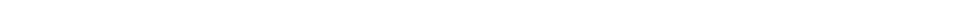
(see fi gure on previous page) Fig. 5 Cytotoxicity of BSO and DPI combinatory treatment in murine KPC cells. A qRT-PCR analysis of pancreatic CYBA gene expression. At 60 days of age, randomly recruited male and female fElas CreERT ( n = 4), KRAS G12D/ + ( n = 3), and KPC mice ( n = 6) were treated with TM. Three weeks post TM induction, the pancreata were collected for RNA extraction. β -actin serves as a control. B An equal number of KPC cancer cells were seeded in 6-well plates and treated with DPI at 0, 3, or 10 μ M in the presence or absence of 100 μ M BSO for 48 h. Cell morphology, population growth, and death were observed under a light microscope. KPC cells without any treatment served as the control. Scale bar, 200 μ m. C Total cellular glutathione (GSX) was measured after 24 h of BSO treatment at 0, 100, or 200 µM in KPC cells by spectrophotometry. D KPC cancer cells were treated with 3 or 10 μ M DPI alone, 100 µM BSO alone, or the combined DPI (1 or 3 μ M) and BSO (100 μ M) for 48 h. Cell death rates were probed by annexin-V/PI assay. KPC cells without any treatment served as the control. E KPC cells were treated with 10 μ M DPI and 100 μ M BSO in the presence or absence of 2 mM NAC for 48 h to assess the changes in cell death rates by fl ow cytometry using the annexin-V/PI assay. F Statistical analysis of KPC cell death rates in E . Data are mean ± SD of three independent experiments with Student ’ s t test. * p < 0.05, ** p < 0.01, *** p < 0.001, **** p <